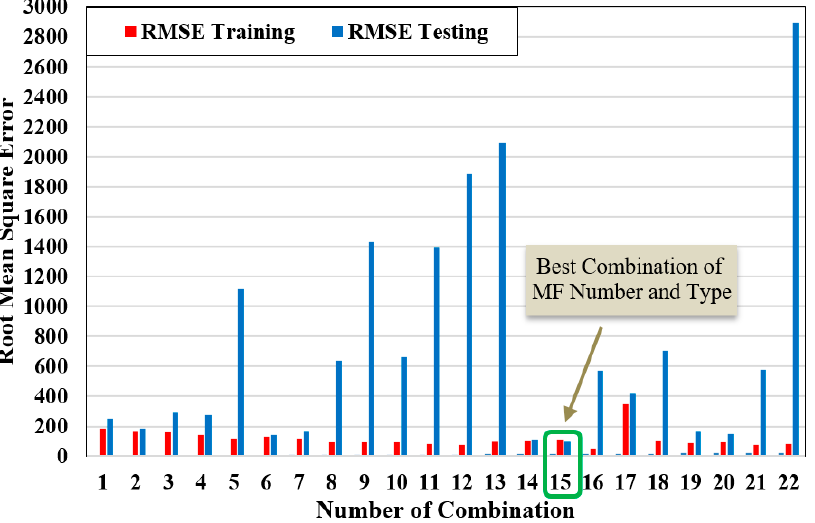
Figure 5. Root mean square error (RMSE) graph of 22 membership function combinations.